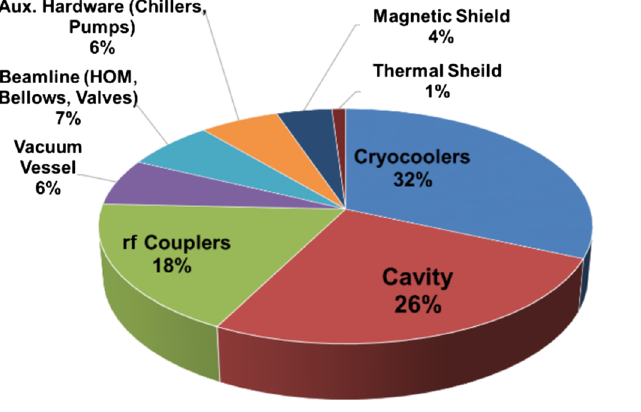
FIG. 28. Cost breakdown of the SRF cryomodule assembly.